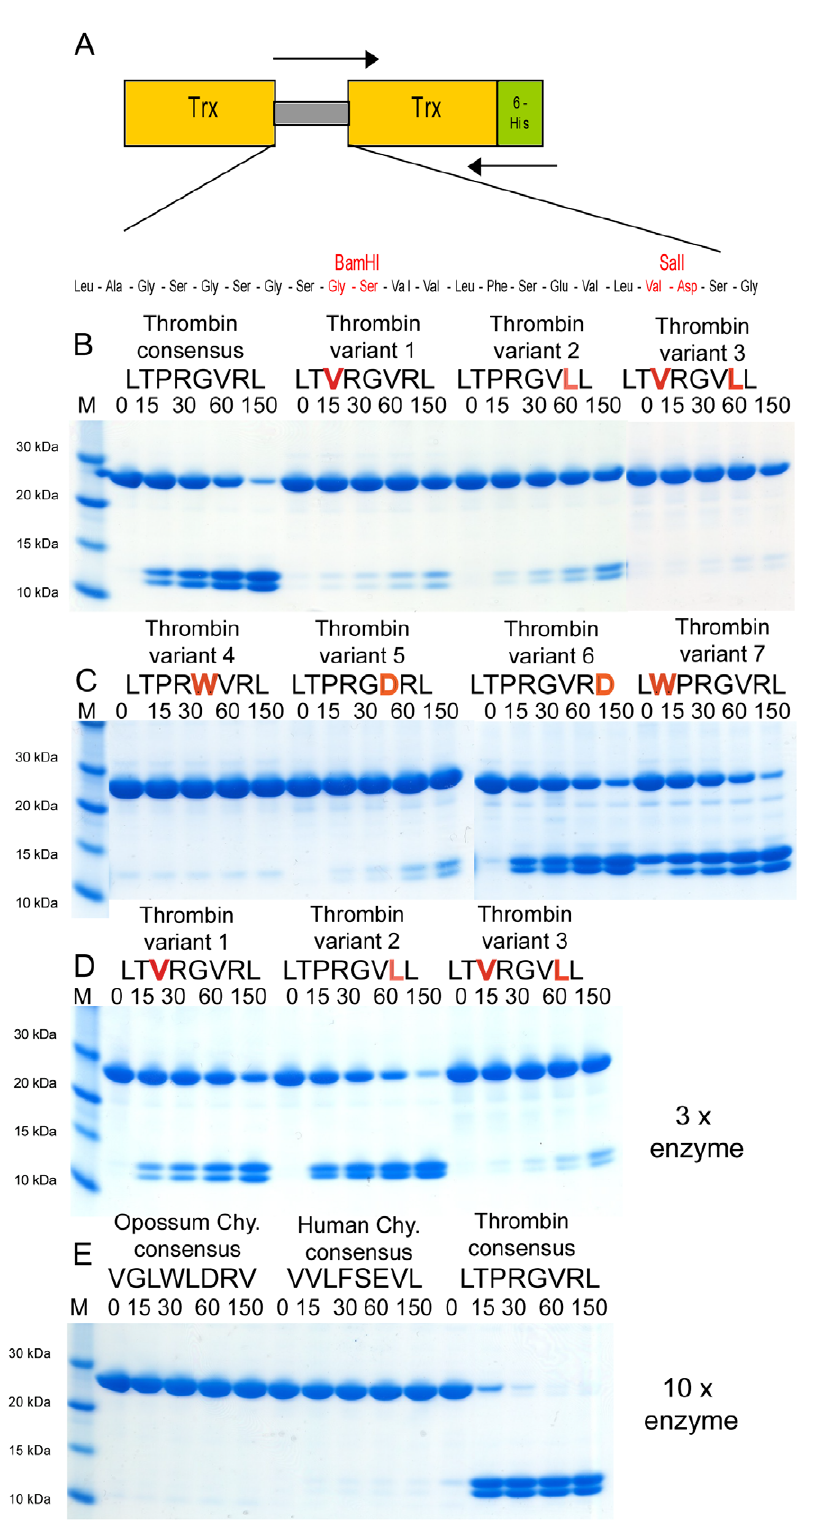
Figure 3. Analysis of the cleavage specificity by the use of new types of recombinant protein substrate. Panel A shows the overall structure of the recombinant protein substrates used for analysis of the efficiency in cleavage by thrombin. In these substrates two thioredoxin molecules are positioned in tandem and the proteins have a His 6 -tag positioned in their C termini. The different cleavable sequences are inserted in the linker region between the two thioredoxin molecules by the use of two unique restriction sites, one Bam HI and one SalI site, which are indicated in the bottom of panel A. Panels B to E shows the cleavage of a number of substrates by thrombin, where individual amino acids has been changed from the thrombin consensus sequence. The name and sequence of the different substrates are indicated above the pictures of the gels. The time of cleavage (in minutes) is also indicated above the corresponding lanes of the different gels. The uncleaved substrates have a molecular weight of approximately 25 kDa and the cleaved substrates appear as two closely located bands with a size of 12–13 kDa.